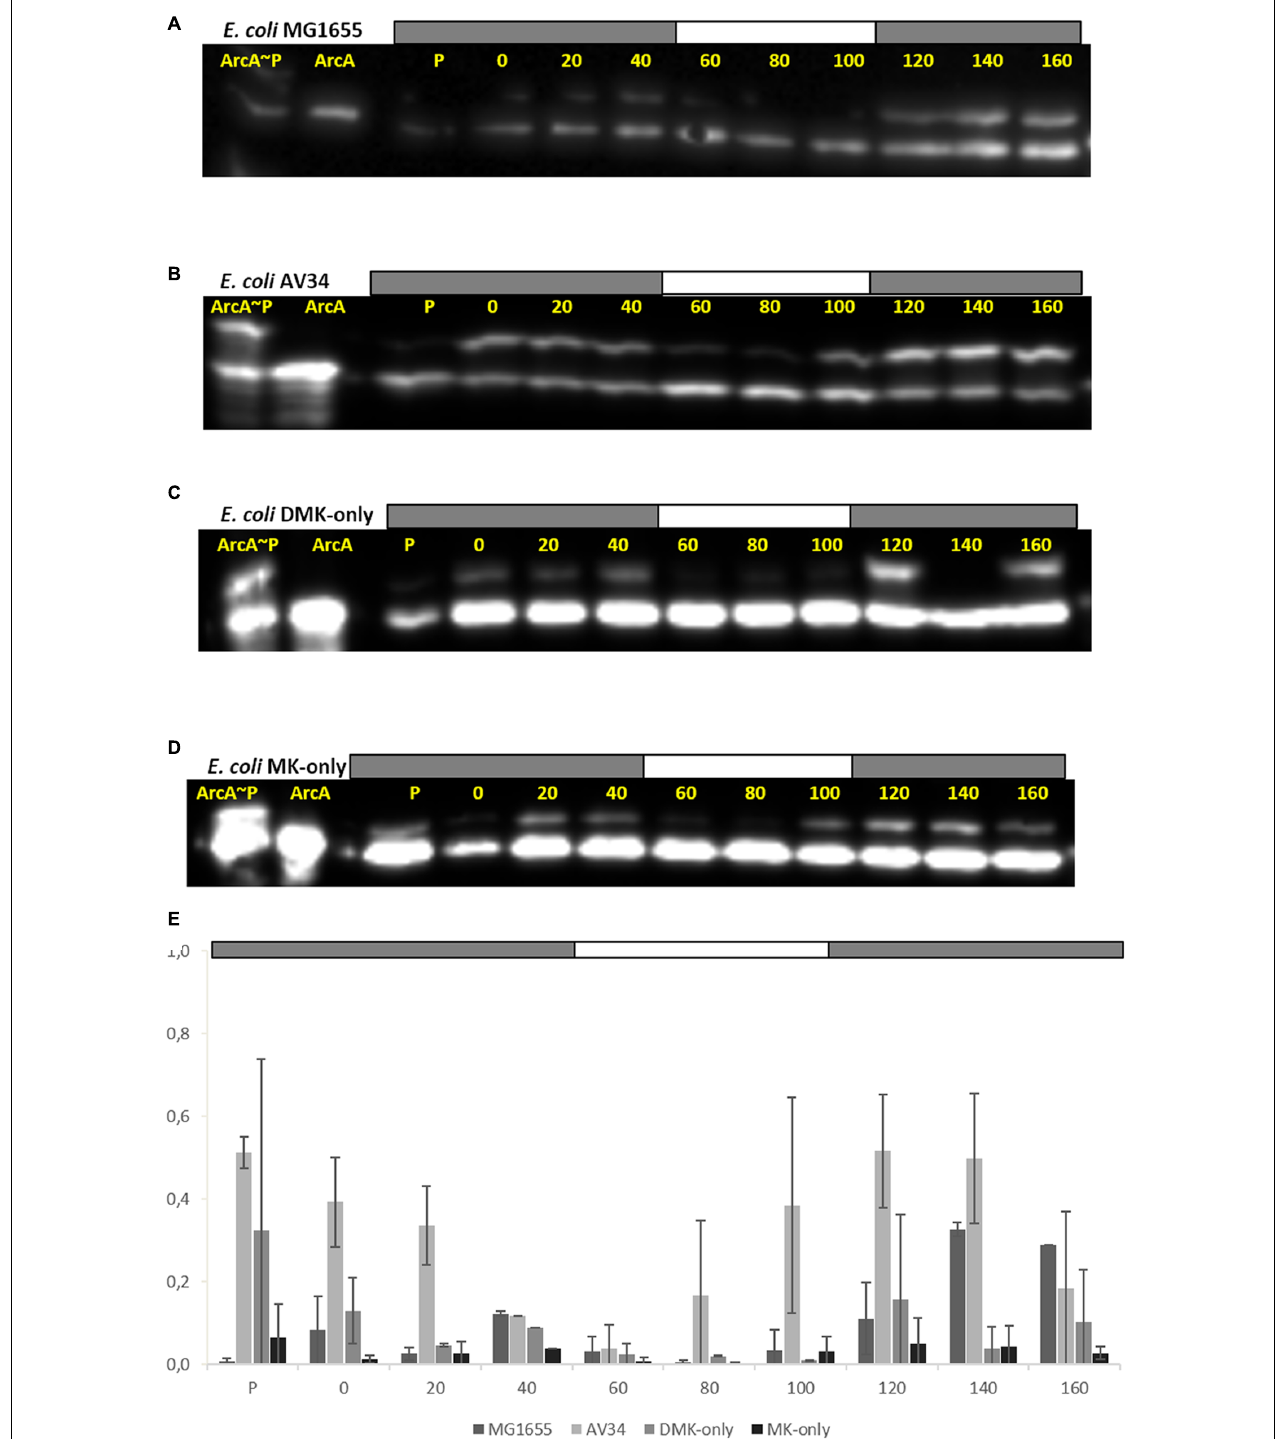
FIGURE 4 | All quinones of E. coli can both reduce (activate) and oxidize (inactivate) ArcAB/A. ArcA ∼ P Phos-Tag Western Blot of E. coli strain used in this study. The lower band represents ArcA while the upper band represents ArcA ∼ P, which is slowed down by the Phos-Tag gel during electorphoresis. The first two lanes are reserved for the ArcA standard, and in-vitro phosphorylated ArcA, respectively. P indicates the pre-culture and the other lanes the sampling time (min). The bar on top of (A–D) indicates N 2 (gray) or air (white) sparging. (A) E. coli MG1655, (B) E. coli AV34 (UQ-only), (C) E. coli DMK-only, (D) E. coli MK-only, (E) Graph of the phosphorylation level of ArcA in the different strains used in this study. The bar graphs shows the results of densitometric quantitation of the ArcA ∼ P/ArcA ratio. Data represent the average of three biologically independent replicates, error bars indicate the standard deviation.